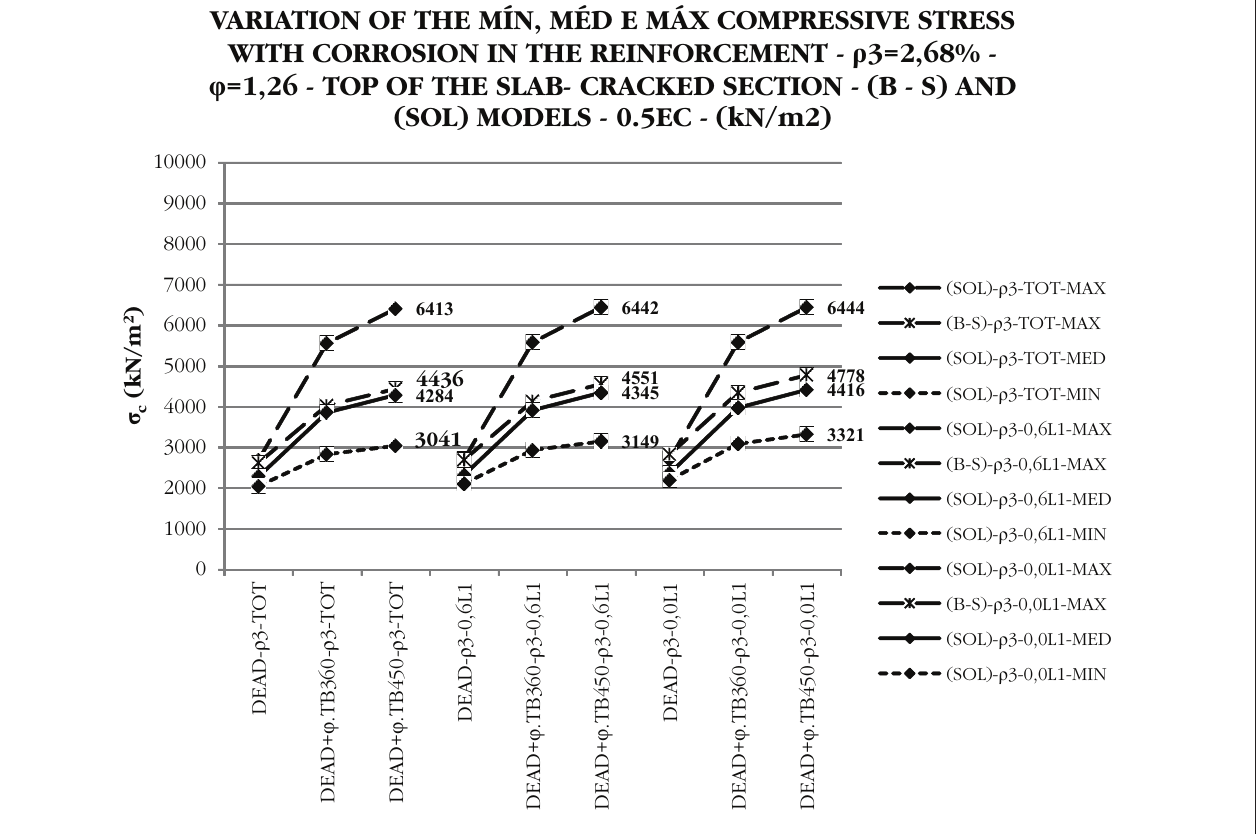
Figure 20 – Variation of minimum, medium and maximum longitudinal compressive stress in the top of the slab versus ρ for (B-S) and (SOL) models, in cracked section, modulus of elasticity 0.5.E , with impact, caused by {DEAD}, {DEAD + φ .TB360} and {DEAD + φ .TB450}, with reinforced